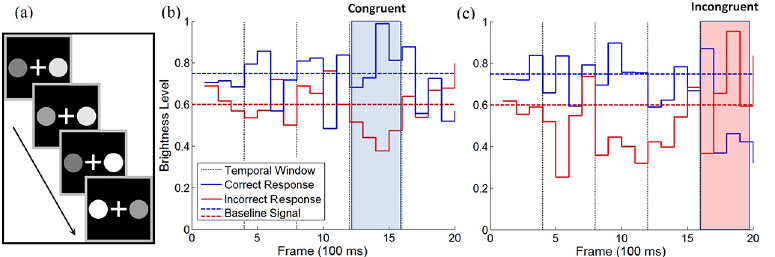
Fig 3. Stimuli and experimental design. A) Illustration of the stimuli in Experiment-1: Participants were presented with two disks which fluctuated in brightness, and were requested to choose the overall brighter disk at the end of each trial; B-C) Illustration of a congruent signal-perturbation in the 4 th temporal window (blue shaded; B) and an incongruent perturbation in the 5 th window (red shaded; C) in 2 sec trials. Solid lines depict brightness level after a perturbation, dashed horizontal lines illustrate the baseline brightness levels for the correct (blue) and incorrect (red) responses. Dashed vertical lines show the temporal windows (4 frames in the 2-sec